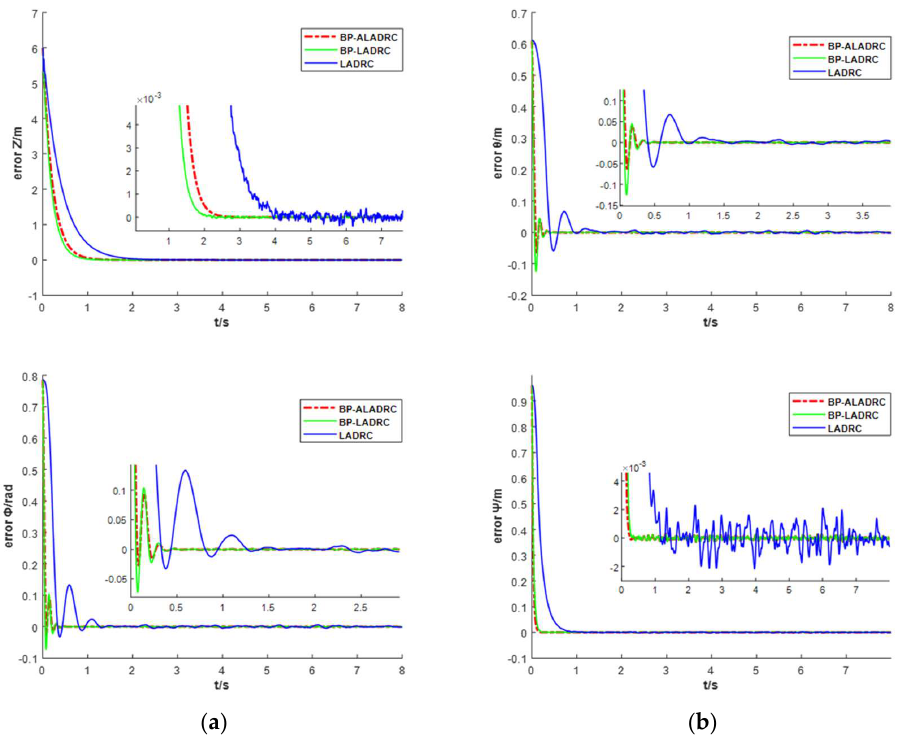
Figure 8. System output errors: (a) Altitude and Roll angle output errors; (b) Pitch and Yaw angle output errors.